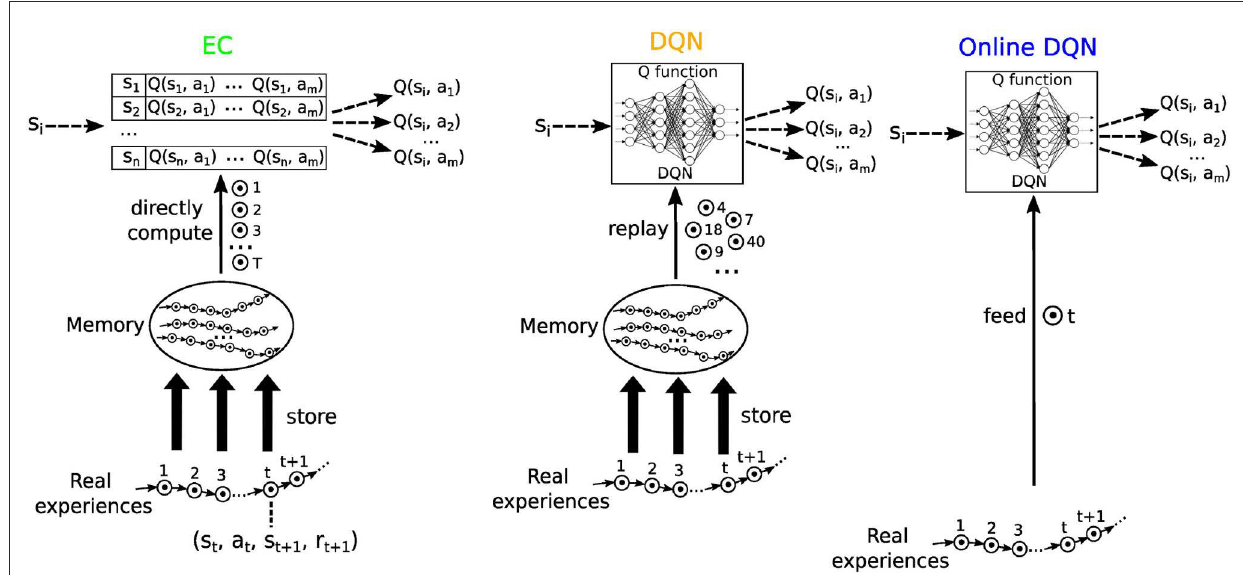
FIGURE4 A schematic illustration of the three reinforcement learning algorithms used in this study. Each circle with a dot inside represents an experience, defined as a (state, action, reward, and next state) tuple. Real experiences are collected sequentially and stored in memory. Model free episodic control (EC) uses this sequential information to systematically extract reward information, which are stored in a table of Q -values. The Deep Q network (DQN) replays experiences to train a deep neural network, which then represents the Q function. The online DQN does not store experiences in memory and uses each experience only once to train the deep neural network representing the Q